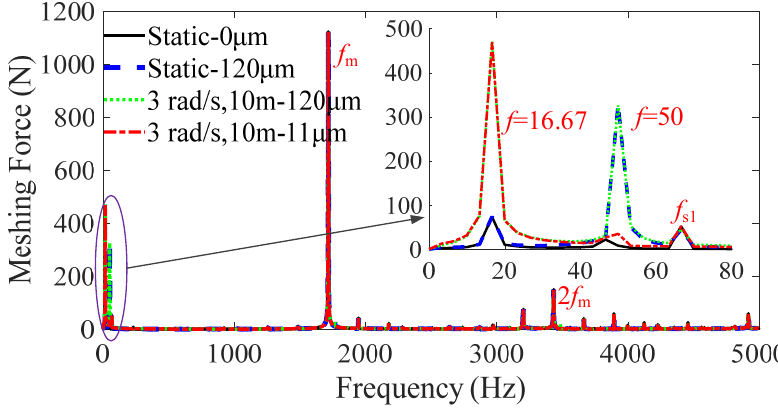
Figure 25. Frequency spectra of the dynamic mesh force of sun-planet1 with manufacturing errors.